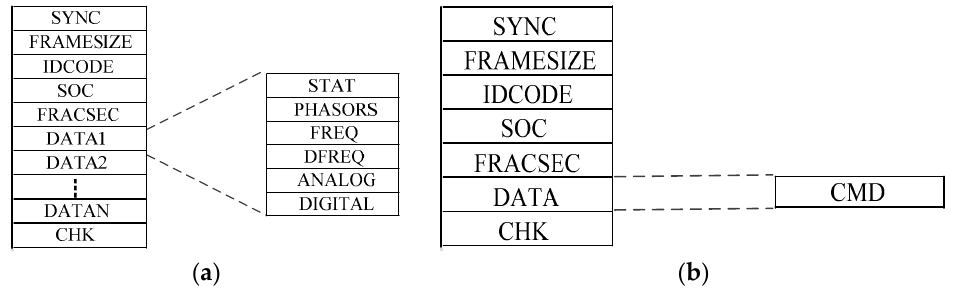
Figure 3. ( a ) GB/T-26865.2-2011 data frame structure; ( b ) GB/T-26865.2-2011 command frame structure.